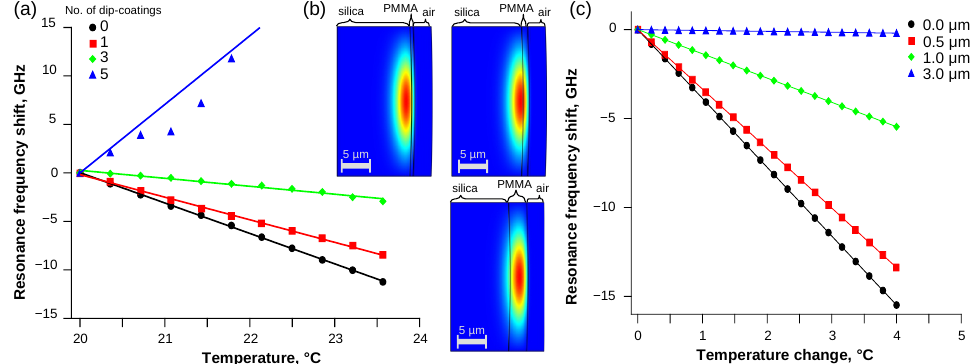
Figure 4. Experimental results show the frequency shift depending on temperature for WGMR in the air ( a ) coated with the PMMA layer is linear and can be fitted with linear approximation. The temperature sensitivity decreased as more layers were added until reversing the resonance shift direction for thicker PMMA layers. Mathematical modeling shows ( b ) fundamental mode moving inside the PMMA coating layer when the thickness increased from 0.5 to 1.0 and 3.0 µ m. ( c ) The temperature sensitivity of the coated WGMR decreased as the PMMA thickness on the 550 µ m silica microsphere